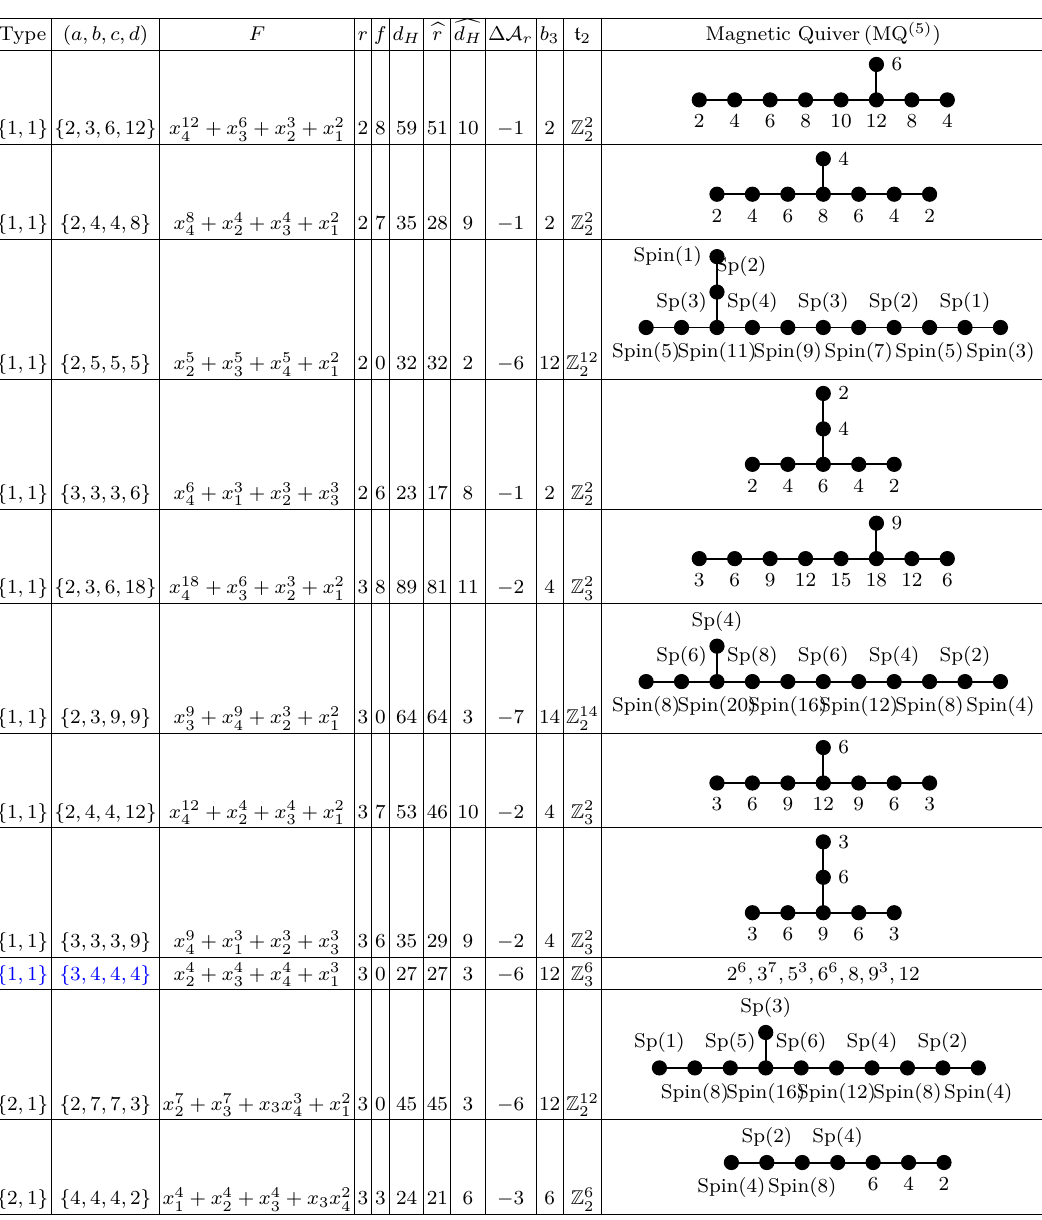
Table 10 . Rank r = 2 , 3 Models with smooth divisors and b 3 > 0 . Blue indicates models with trinion representations in